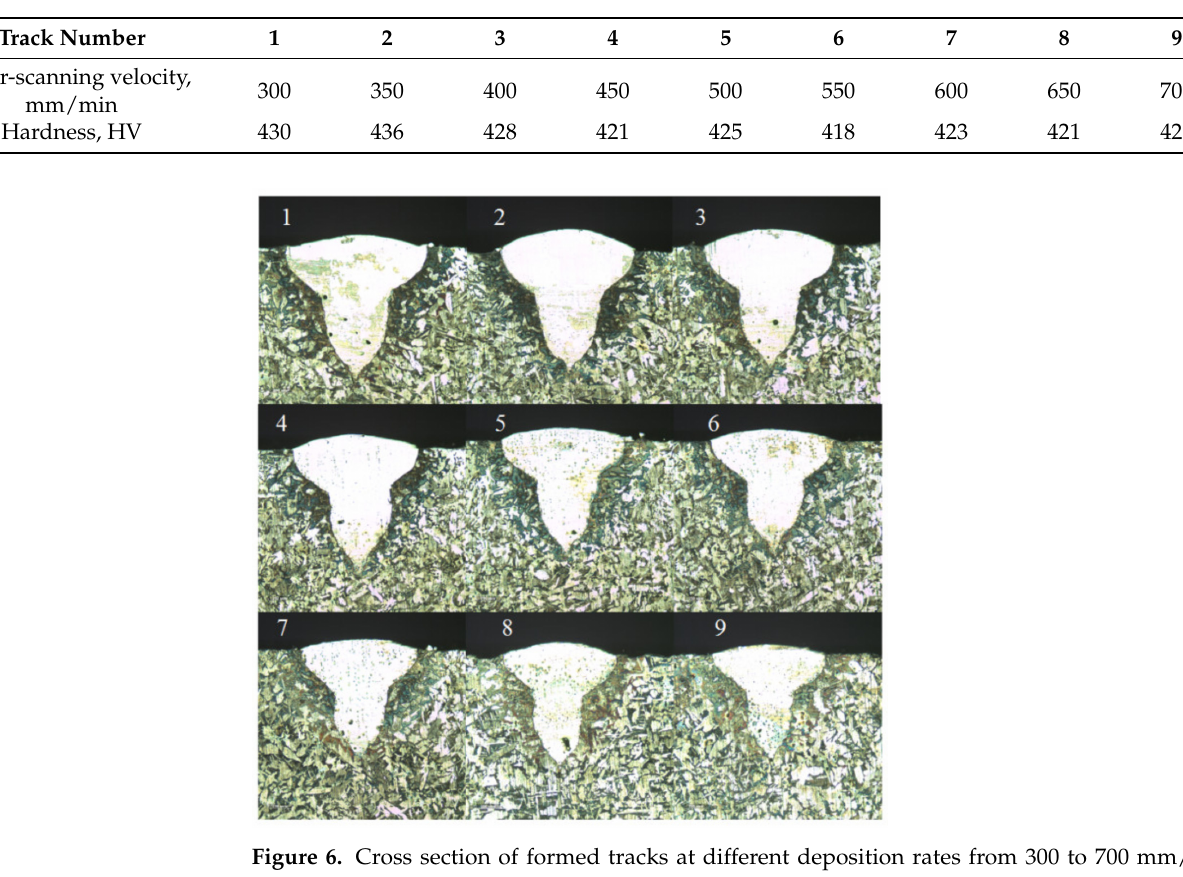
Table 5. The hardness of the deposited beads (HV) depending on the scanning speed of the laser beam, P = 400 W.